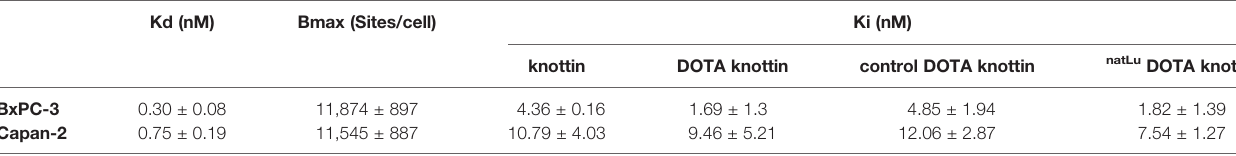
TABLE 1 | Saturation and competition binding assay results using 125 I DOTA-integrin a v b 6 knottin for BxPC-3 and Capan-2 cells. Kd (nM) Bmax (Sites/cell) Ki (nM) knottin DOTA knottin control DOTA knottin natLu DOTA knottin BxPC-3 0.30 ± 0.08 11,874 ± 897 4.36 ± 0.16 1.69 ± 1.3 0.75 ± 0.19 11,545 ± 887 Data are presented as mean ± S.E.M. (3 ≤ n ≤